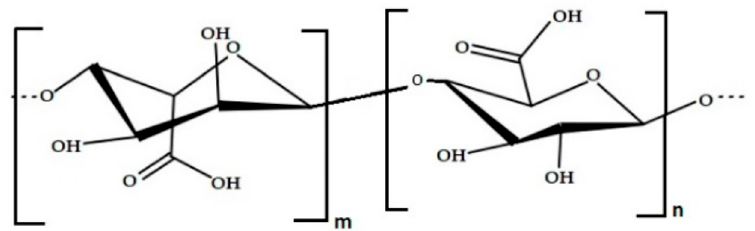
Figure 1. Chemical structure of alginic acid.